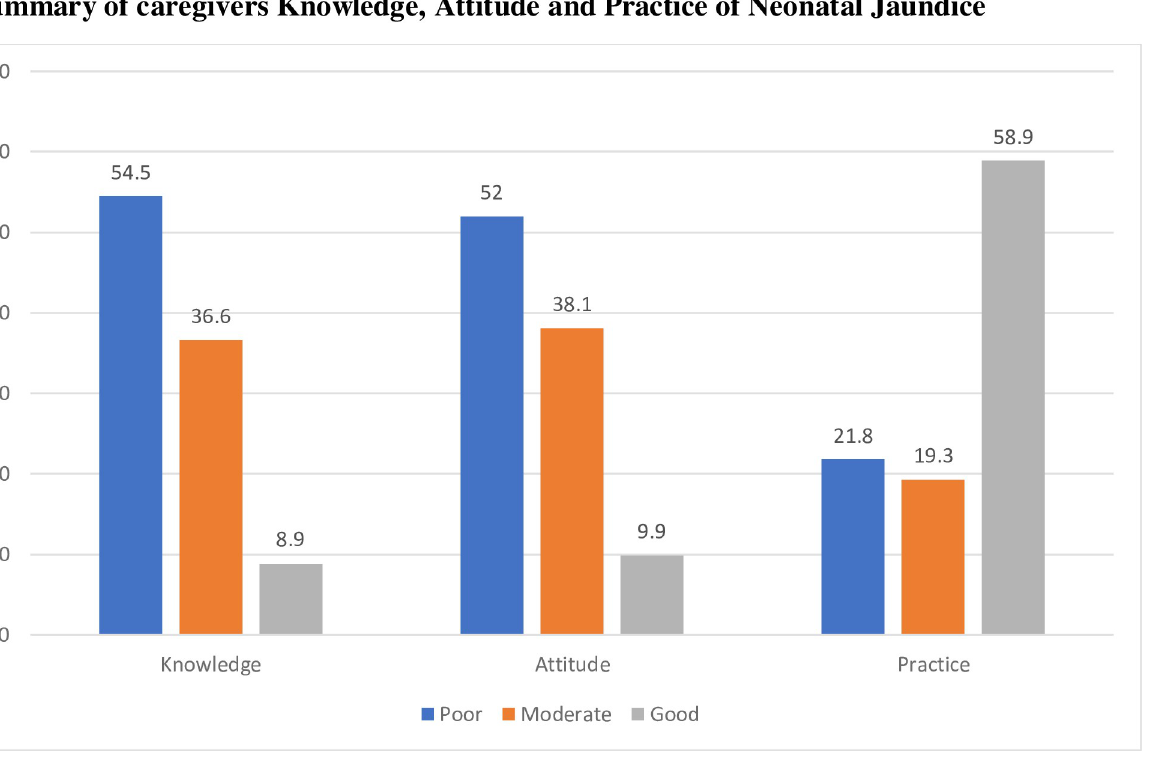
PLOS ONE | https://doi.org/10.1371/journal.pone.0251846 June 4,